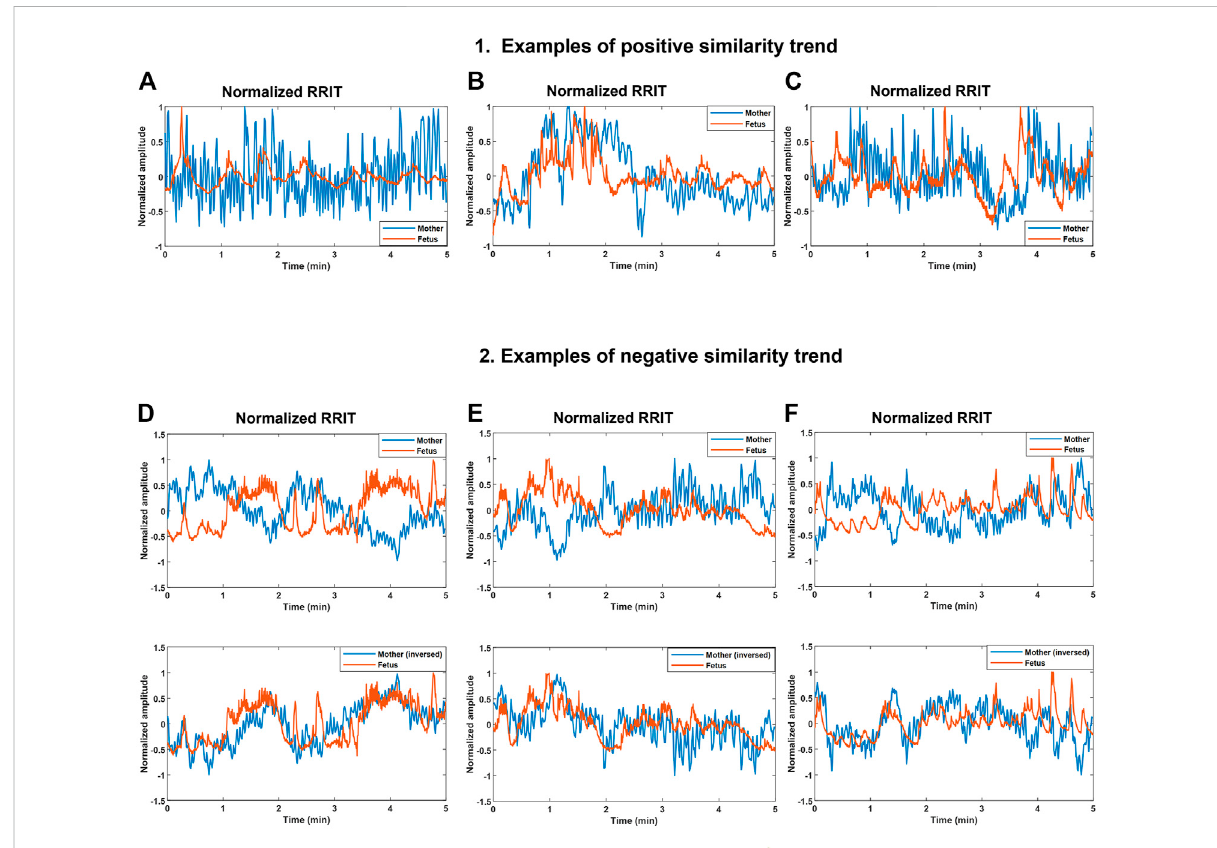
FIGURE 3 Demonstration of positive and negative similarity trends between maternal and fetal RR interval tachograms (bmfRRITs). Figures (A – C) show examples of positive similarity trends in which maternal (blue) and fetal (orange) RRITs change in the same direction. Figures D, E and F (D – F) show examples of negative similarity trends in which maternal and fetal RRITs change in opposing directions. The upper panels in Figures (D – F) show the original signals while the lower panels show the original fetal signal with the maternal signal inversed. (A) The record belongs to a mother who had no records of medical complications, gestational age (GA): 20 weeks. (B) The record belongs to a mother with a record of uterine/appendix disease, GA:23 weeks. (C) The recordbelongstoamotherwithamedicalrecordofrespiratorydiseaseanduterine/appendix disease, GA:20